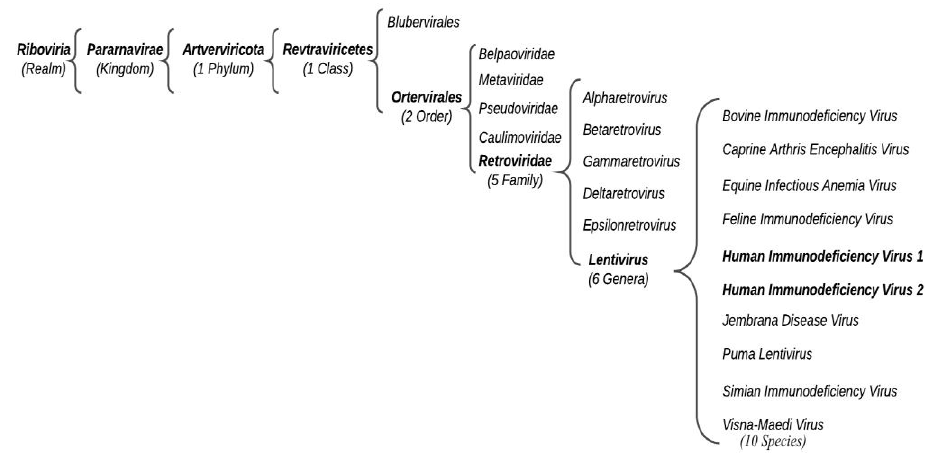
Figure 1. Schematic representation of HIV current classification.